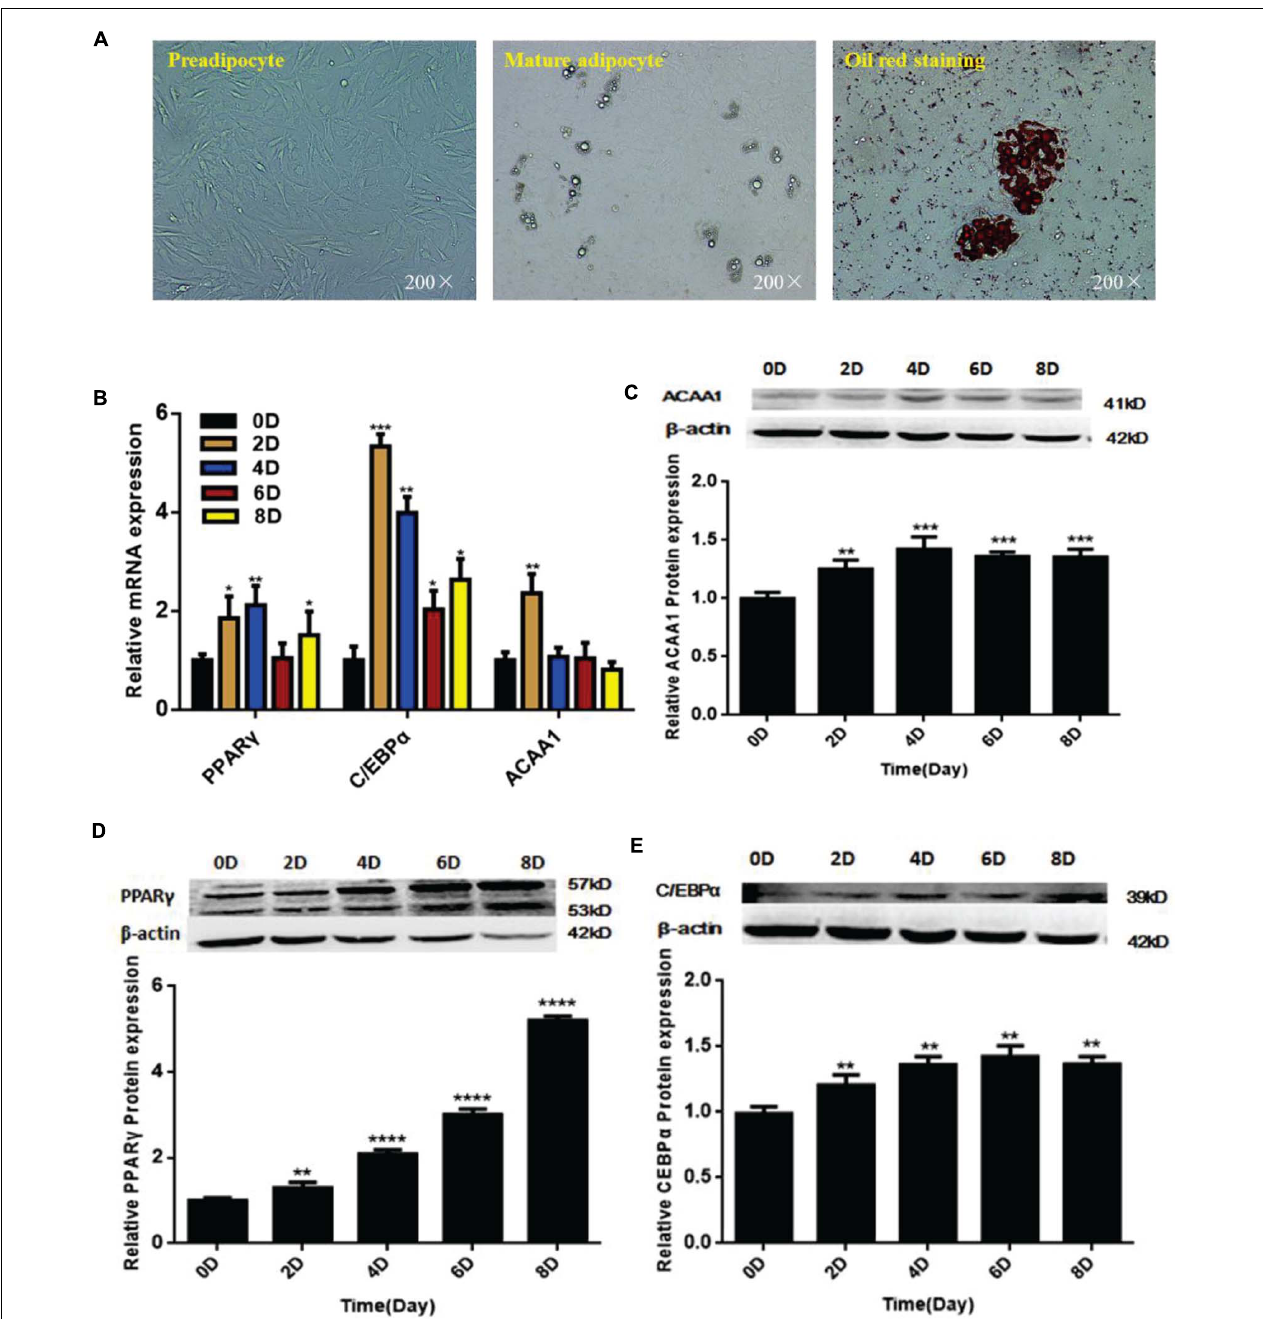
FIGURE 1 | ACAA1 and adipogenic marker gene expression during sheep preadipocyte differentiation. (A) Sheep preadipocytes, mature adipocytes, and oil red O staining (200 × ). (B) Expression patterns of adipogenic marker genes ( PPAR γ and C/EBP α ) in differentiating sheep adipocytes. (C) ACAA1 protein expression in differentiating sheep adipocytes was determined by Western blot analysis. (D,E) The protein expression levels of PPAR γ and C/EBP α during adipocyte differentiation were evaluated on days 0, 2, 4, 6, and 8. Densitometric analyses of the Western blots. With the differentiation of cells, the expression levels of adipogenic genes gradually increased (* p < 0.05, ** p < 0.01, *** p < 0.001, and **** p < 0.0001). ACAA1 , acetyl-CoA acyltransferase 1; PPAR γ , peroxisome proliferator-activated receptor γ ; C/EBP α , CCAAT/enhancer binding protein α .